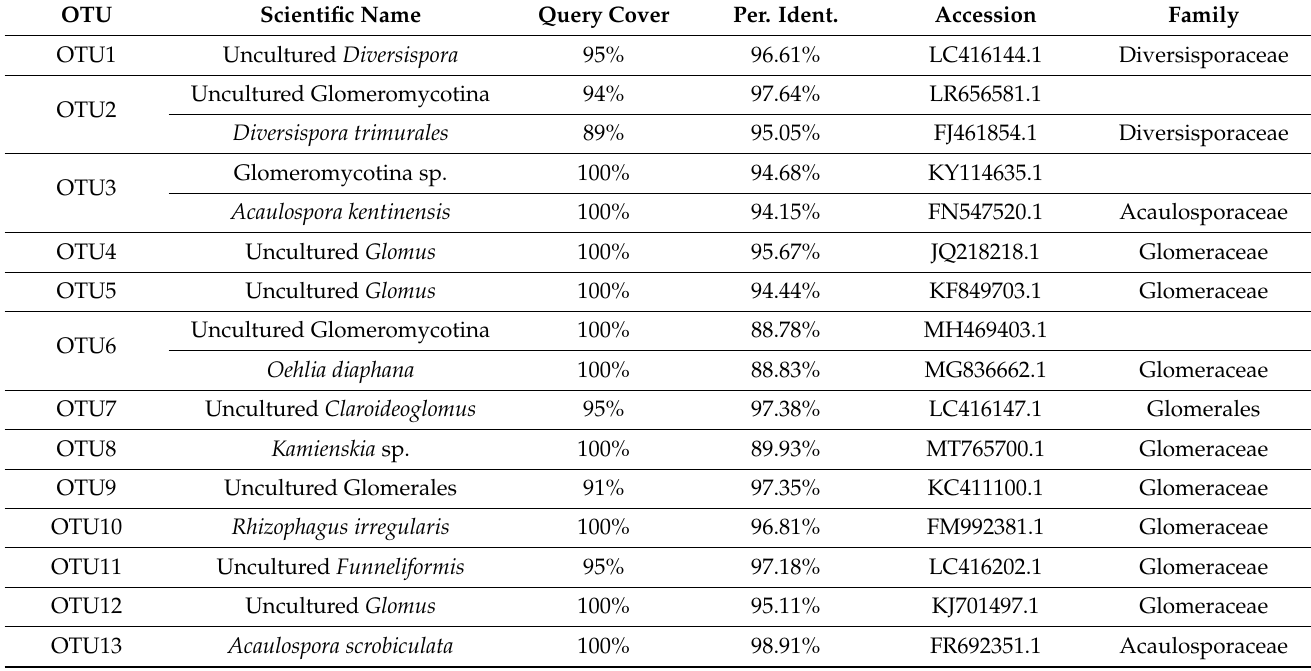
Table A3. Blast (GenBank database) of representative arbuscular mycorrhizal (AM) fungal OTUs associated to roots of sacha inchi in four localities of the San Mart í n region, Peru. First record is shown and, in case, the first record matching a known AM fungal species, per each